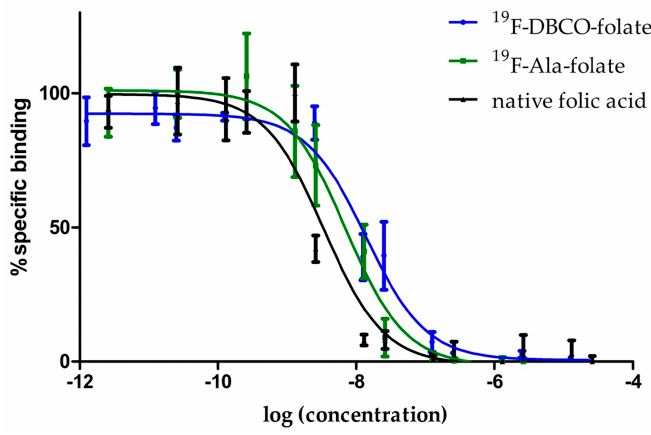
Figure 1. Displacement assay: % specific bound [ 3 H]folic acid against 19 F-DBCO-folate and 19 F-Ala-folate.